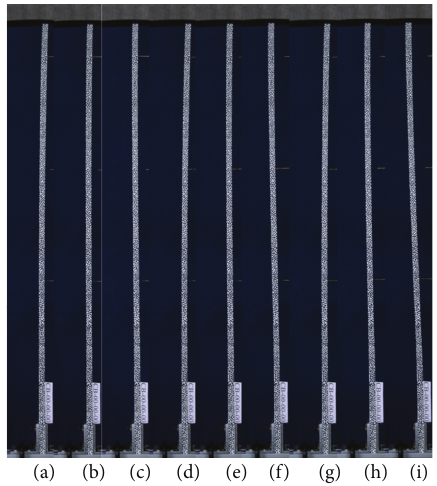
Figure 7: The images are taken apart for analyzing the object defor- mation and movement.